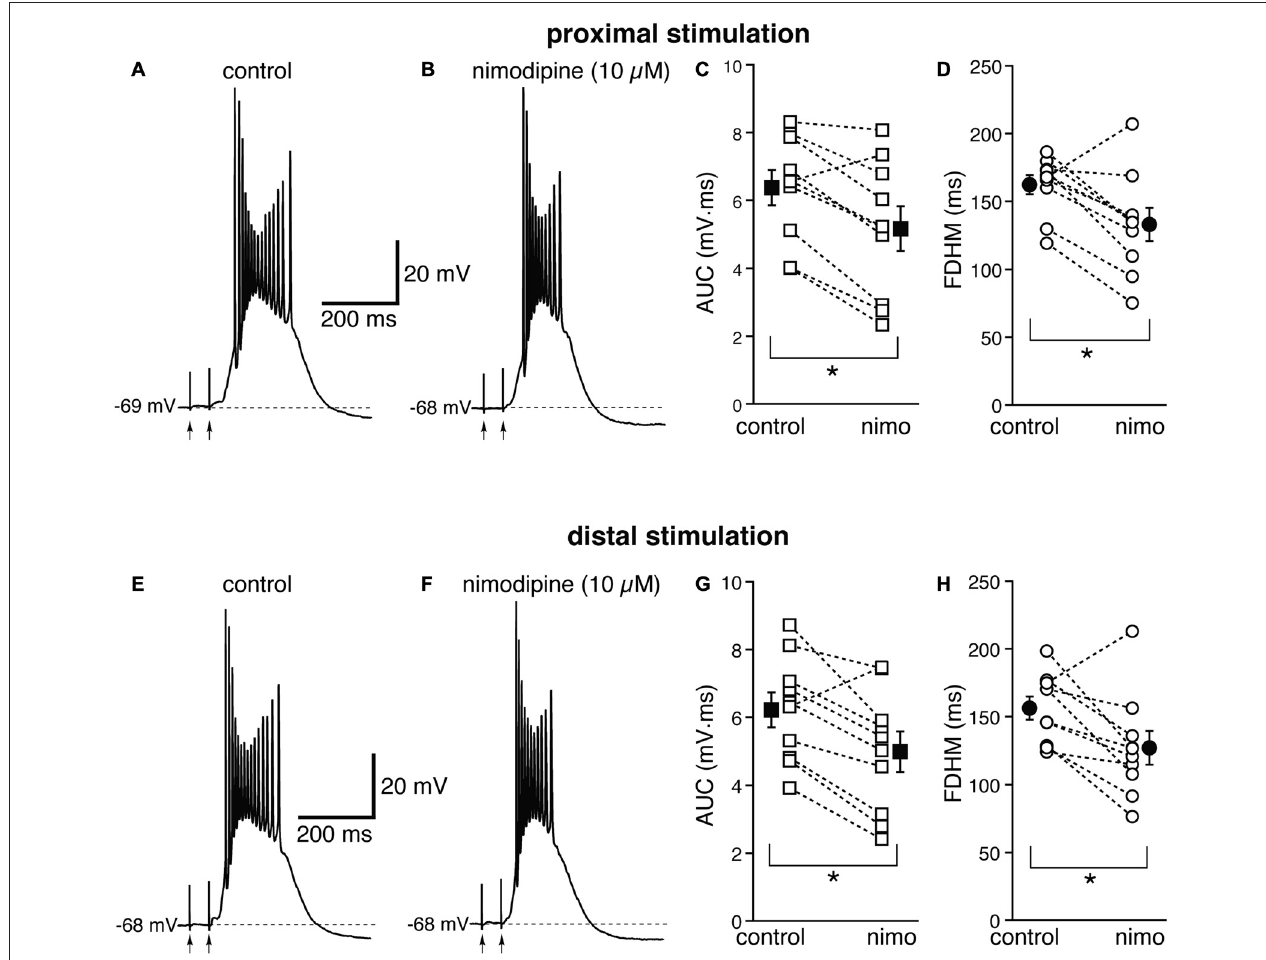
FIGURE 4 | The L-type Ca 2 + channel blocker nimodipine reduces the bursts in EC layer V neurons, at both proximal and distal locations. Top, representative trace of a burst recorded upon stimulation of proximal afferent fibers in control conditions (A) and in the presence of nimodipine (10 µ M, B ). Nimodipine reduced the AUC (C) by 21 ± 6%, and the FDHM (D) by 19 ± 6% in n = 10 neurons. Bottom, representative trace of a burst recorded upon stimulation of distal afferent fibers in control conditions (E) and in the presence of nimodipine (F) . Nimodipine reduced both the AUC (G) by 21 ± 6%, and the FDHM (H) by 19 ± 6% in n = 10 neurons. Asterisks indicate significant difference between control and nimodipine treatment. There was no statistically significant interaction between the nimodipine treatment and location (two-way repeated measures ANOVA). The traces in (A,B) and (E,F) were recorded from the same neuron.